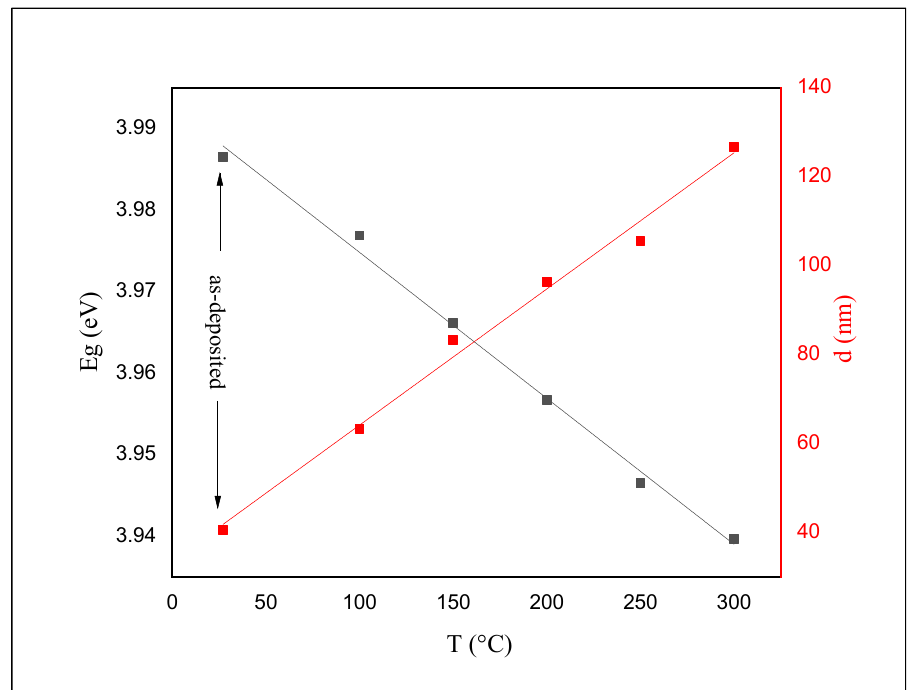
Figure 8. Energy gap and thickness for as-deposited and annealed ZnS thin films as a function of annealing temperature.